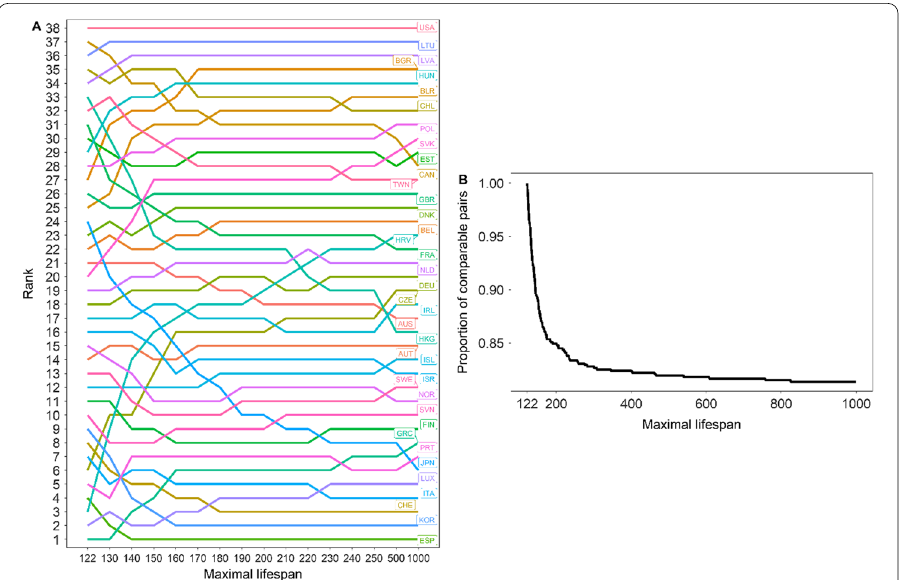
Fig. 8 Country rank ( A ) and proportion of comparable pairs ( B ) by maximal lifespan (horizontal axis), females, 2015 (Source: Authors’ elaboration based on the HMD